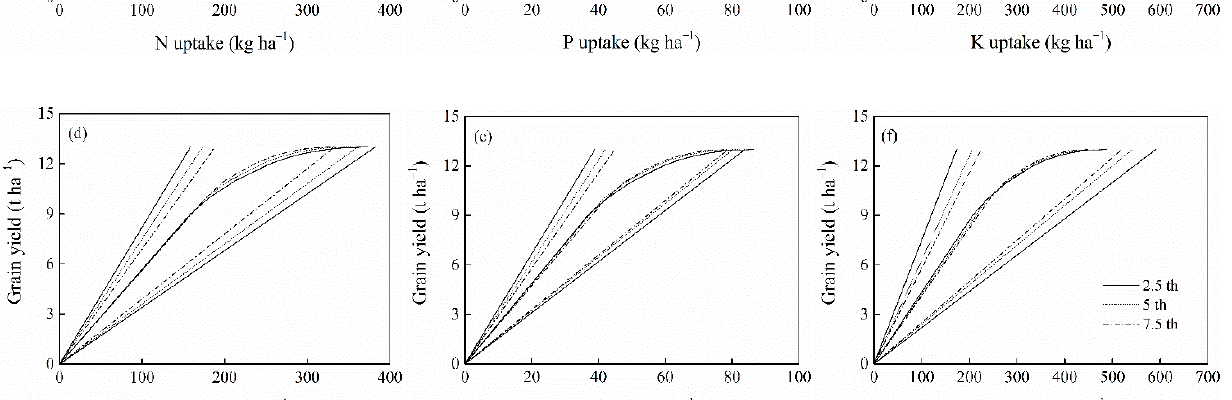
Figure 4. The nutrient requirements of japonica/indica hybrid rice and japonica rice in above-ground dry matter at a grain yield of 13 t ha − 1 , based on Set I.